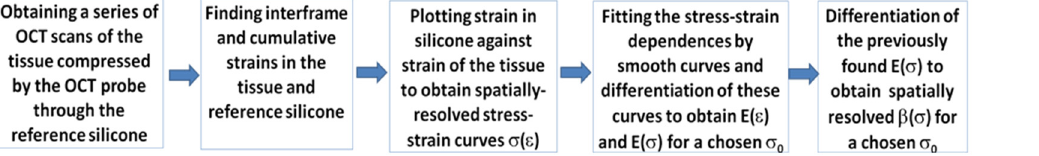
Figure 2. Schematic of the main steps of signal processing to estimate stiffness and the nonlinearity parameter in the developed C-OCE. parameter in the developed